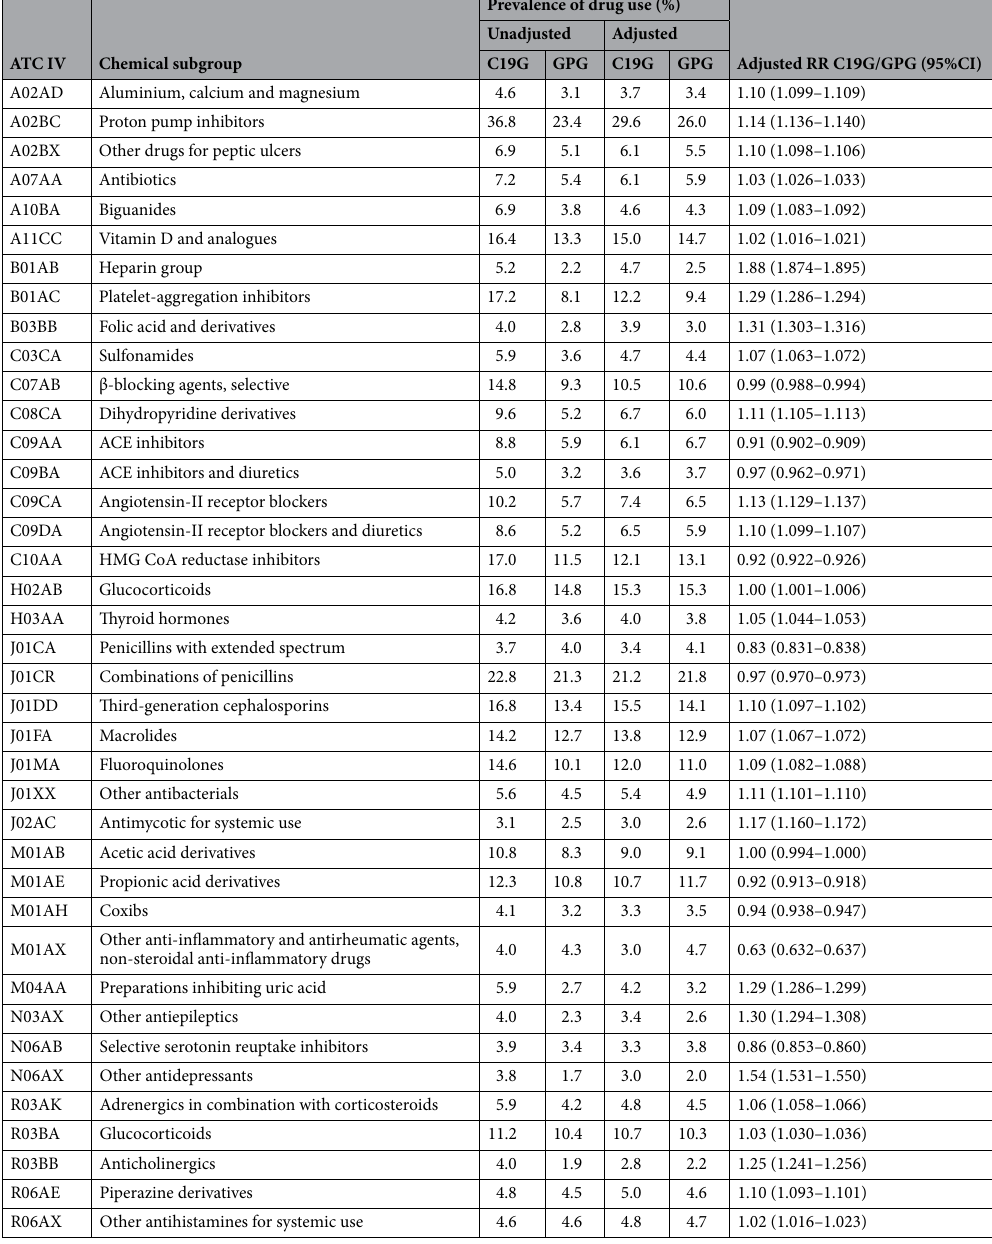
Table 2. Differences in prevalence of drug use between the C19G and GPG according to Chemical Subgroup (ATC IV). C19G COVID-19 group; CI confidence interval; GPG general population group; RR , risk